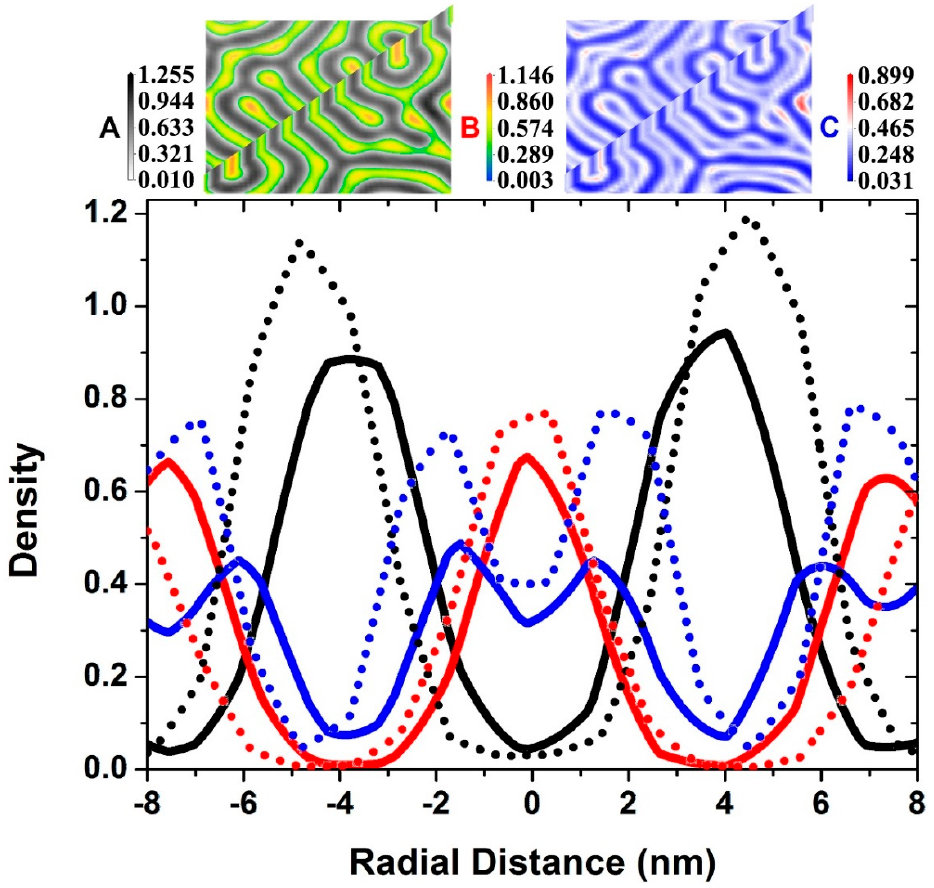
Figure 4. The density profiles of A, B, and C beads of another three adjacent aggregates consisting of B beads are denoted in black, red, and blue lines, respectively, for C[51] interactions at the final equilibrium state. The solid and dotted lines correspond to the 3C2 and 3C3 systems, respectively. Two density images selected from the 3C2 system of A–B beads (left) and C beads (right) are shown on the top and consist of two density slices, with one density slice along the X–Y plane and the other density slice aligned vertically across parallel lamellae (the latter one is vertical to the former one).